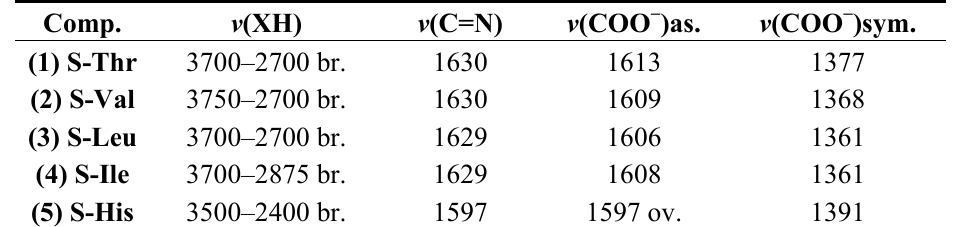
Table 2. Selected IR brands of amino acids ionic liquid-supported Schiff bases 1 – 5 (cm − 1 ). Comp.